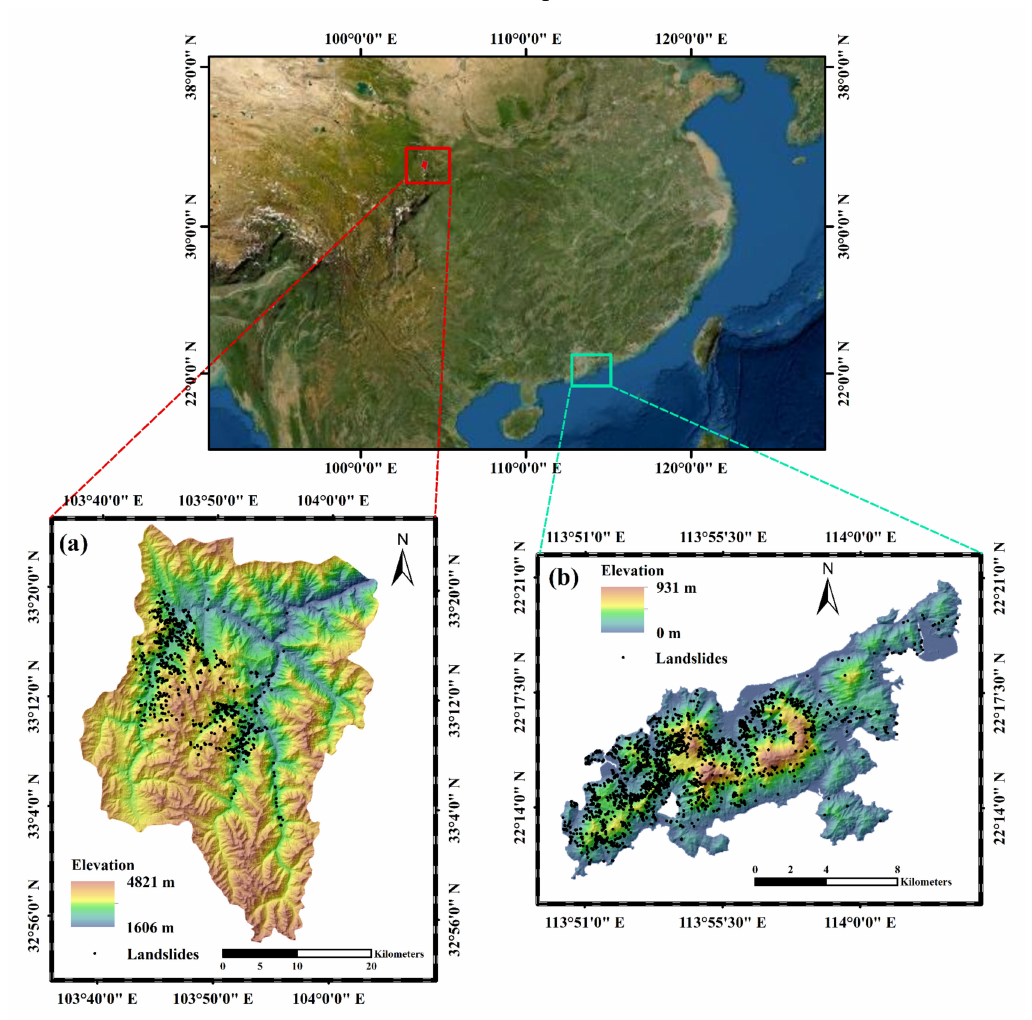
Figure 1. Location of the study areas: ( a ) Zhangzha Town and ( b ) Lantau